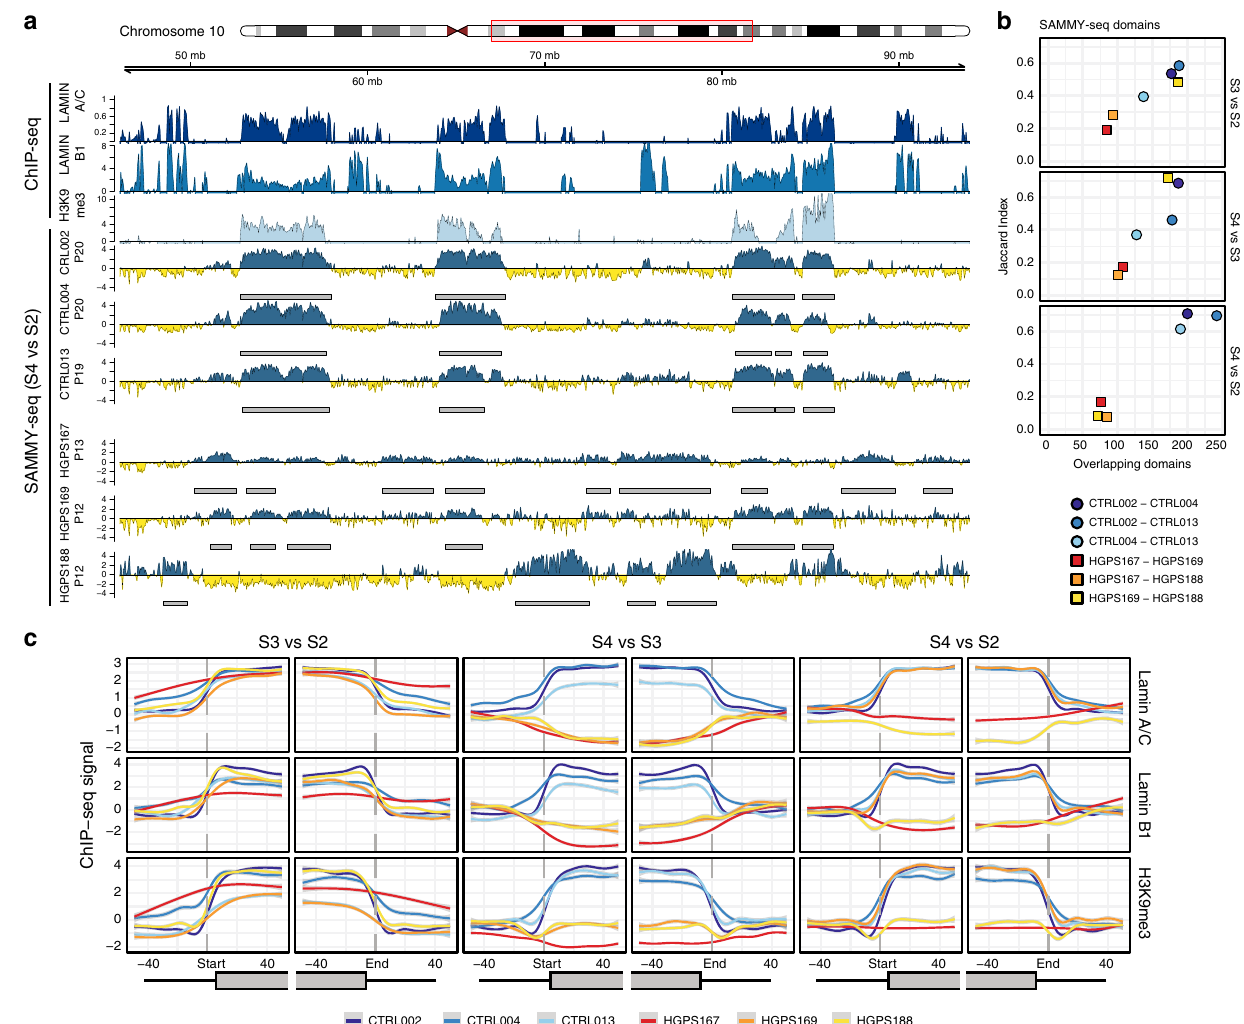
Fig. 3 HGPS fi broblasts show early changes in chromatin accessibility. a Genomic tracks for SAMMY-seq in three control and three HGPS samples at indicated passages (p12-20) along with chromatin marks in a representative region (48 Mb region in chr10:46000000-94000000). From top to bottom: tracks for the association to lamina (Lamin A/C and Lamin B1 ChIP-seq – dark blue and blue); heterochromatin (H3K9me3 ChIP-seq – light blue); SAMMY- seq enrichment signal (S4 vs S2) in three control and three HGPS samples (blue or yellow-colored track for enrichment or depletion, respectively, over the S2 reference baseline). Gray boxes under each SAMMY-seq track show the SAMMY-seq domains. For ChIP-seq data, the (ChIP – input) reads distribution was computed with SPP package and we are limiting the y axis range to zero as a minimum value. b Pairwise overlap of SAMMY-seq domains (S3 vs S2, S4 vs S3, S4 vs S2) between control or HGPS sample pairs (JI on y axis, number of overlapping regions on x axis). Upper-tail Fisher test p -value < 0.01 for all overlaps, except for HGPS S4 vs S2 pairwise overlaps. c Smoothed average ChIP-seq enrichment signal for chromatin marks around SAMMY-seq domain borders. ChIP-seq signal for Lamin A/C (upper row), Lamin B1 (middle row), and H3K9me3 (bottom row) is reported around the SAMMY-seq domain borders start (left side plots) or end (right side plots) for domains detected in each control and progeria sample. Results for each set of SAMMY-seq enrichment domains are reported (S3 vs S2 on the left, S4 vs S3 center, S4 vs S2 on the right) using a ±50 bins window (10 kb bin size) centered on the start or end domain border positions (vertical dashed gray line). The smoothed average is obtained by GAM (see “ Methods ” section) and the gray shaded area under each line shows the 95% con fi dence interval for the fi tted